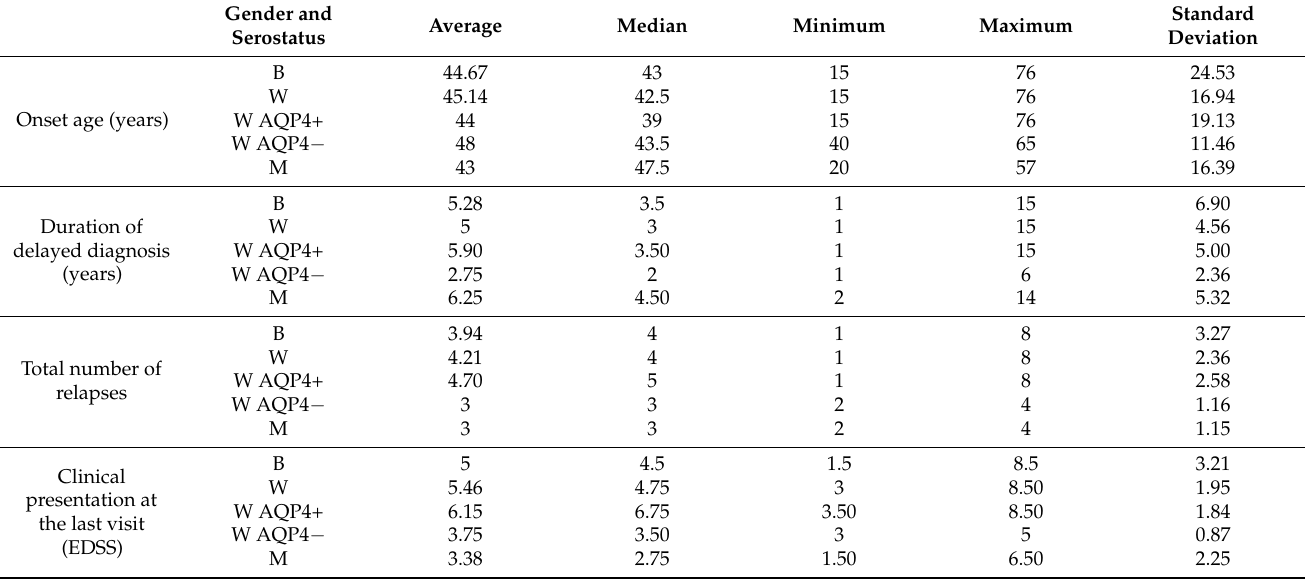
Table 2. Statistical evaluation of data broken down by gender and serostatus. W—women, M— men, B—both women and men, AQP4+—present antibodies against aquaporin 4, AQP4 − —absent antibodies against aquaporin